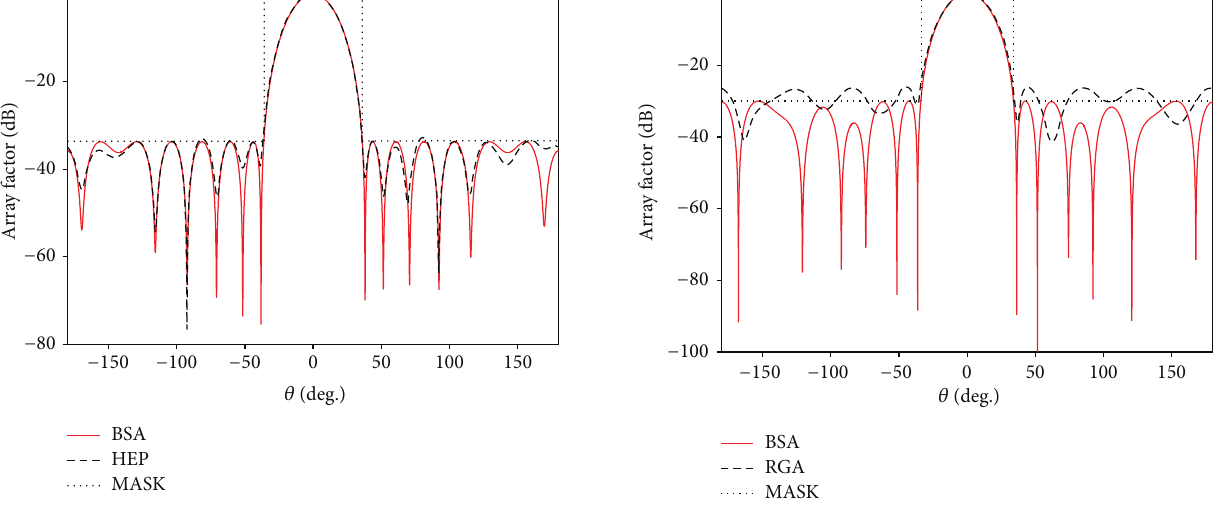
Figure 9: The radiation patterns obtained by BSA and HEP [2] for CCAA without central element.